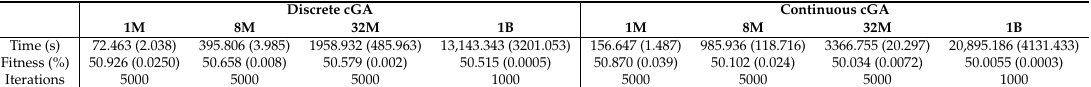
Table A1. Results of the cGA on the discrete and continuous OneMax problem.